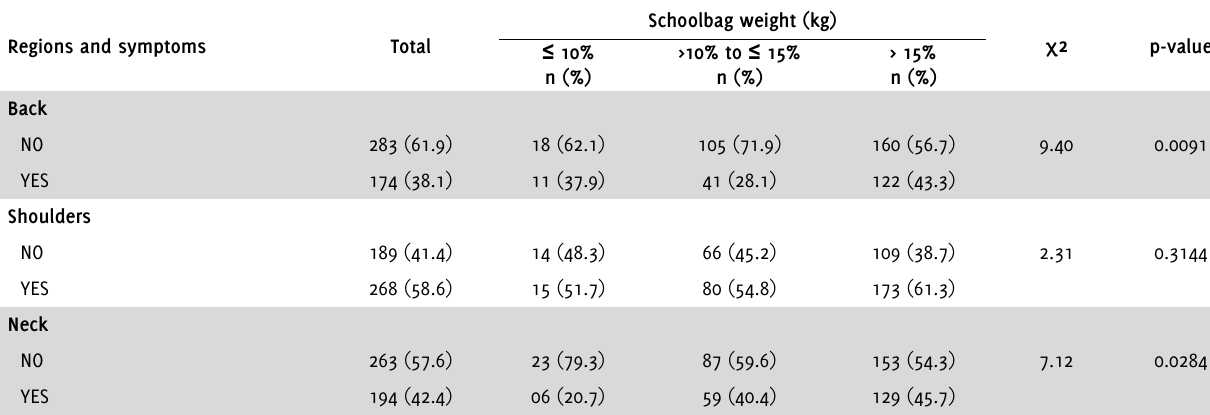
Table 3. Prevalence of pain symptoms in different regions of the body